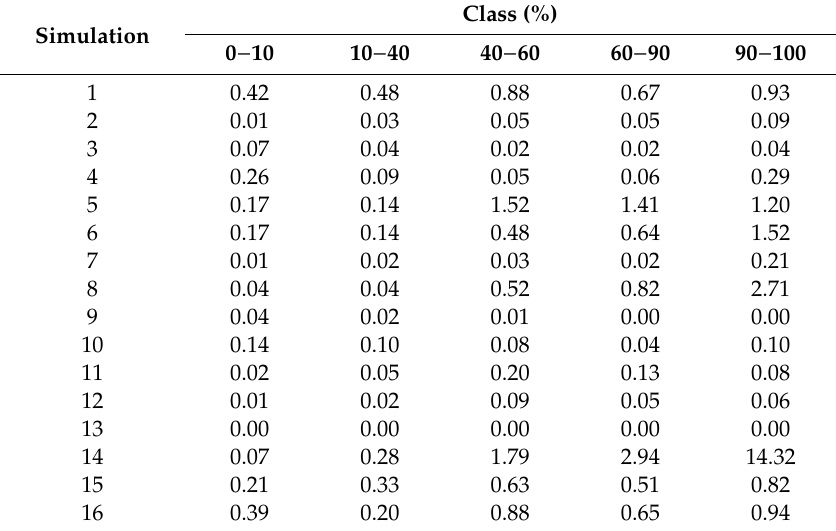
Table 5. Sensitivity index (-) at the station Ulla-Teo for each exceedance probability class of the flow-duration